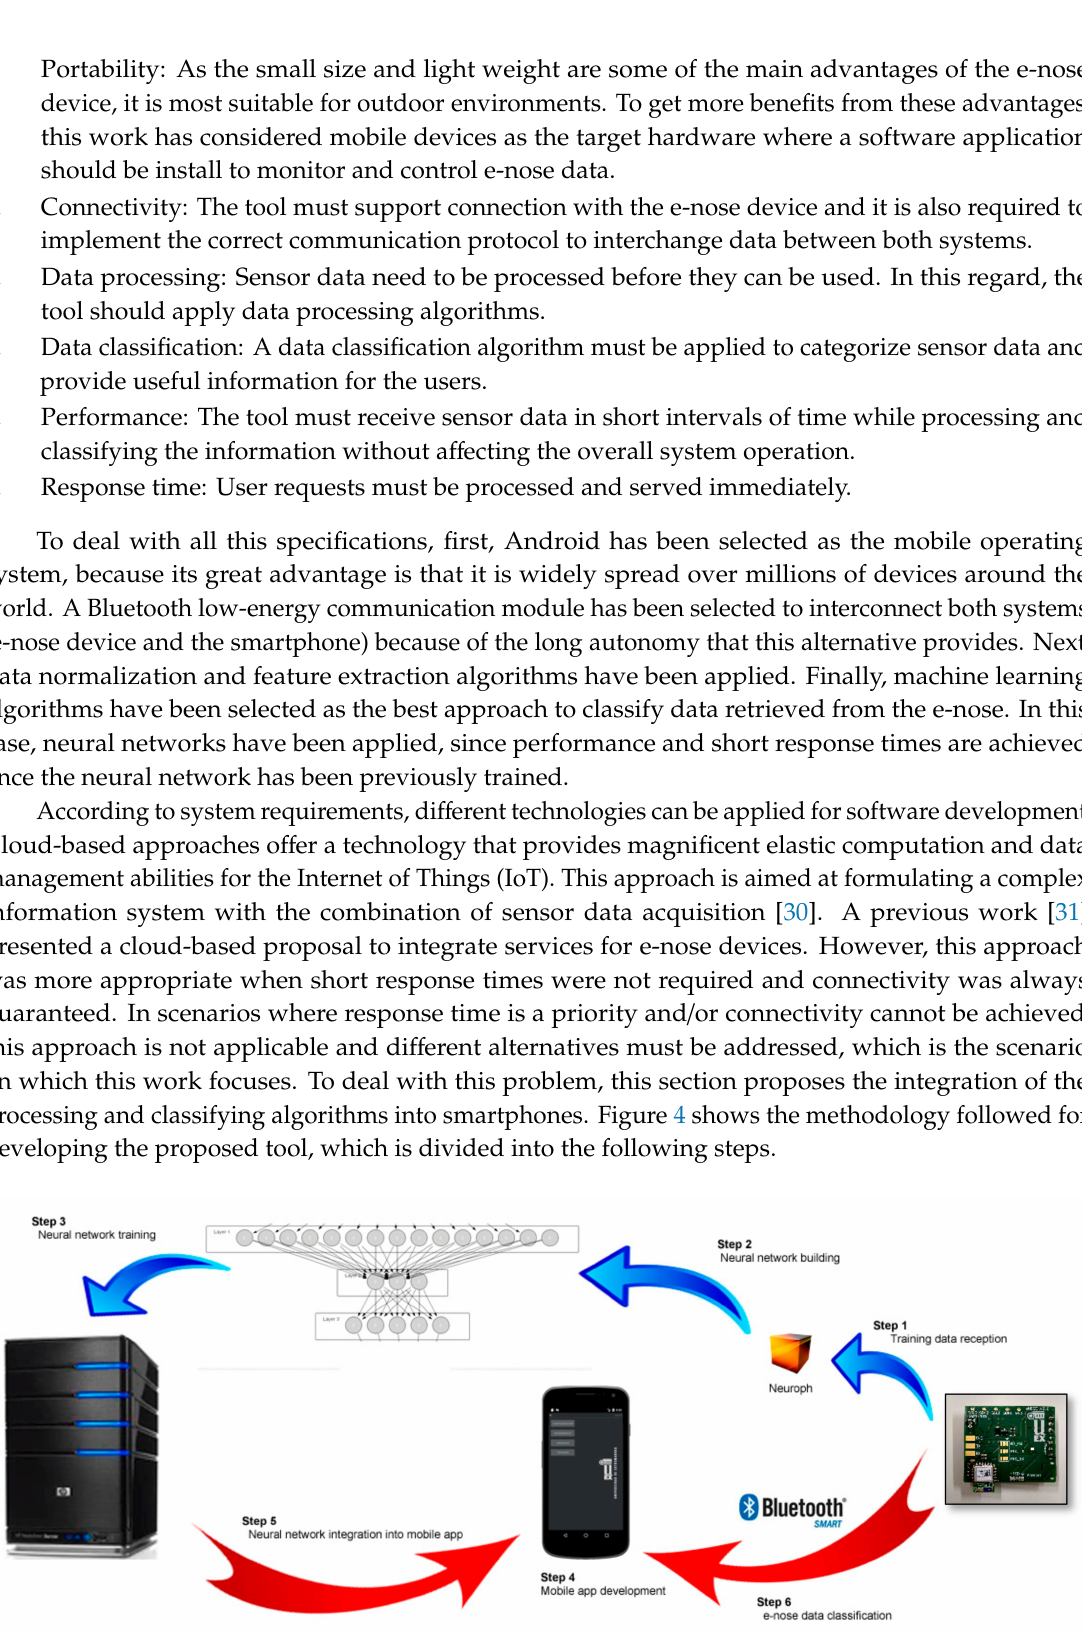
Figure 4. Methodology followed to develop the mobile